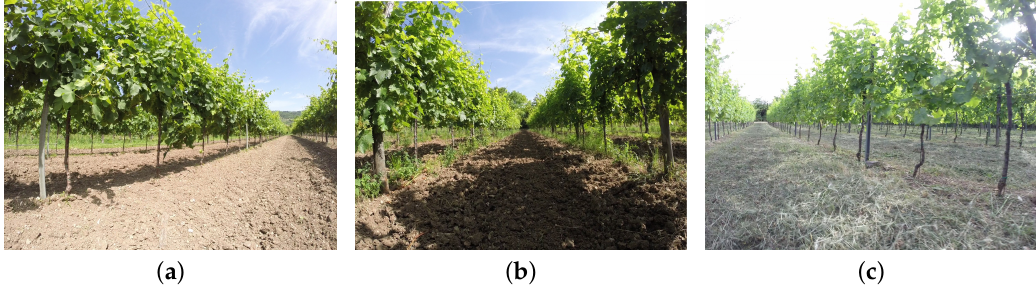
Figure 5. Three samples of the dataset used to train the network, one for each class. ( a ) is an example of the left class, ( b ) of the center class, and ( c ) of the right class. Dataset samples have been collected with different weather conditions and at a different time of day. The resulting heterogeneous training set is aimed at giving generality and robustness to the